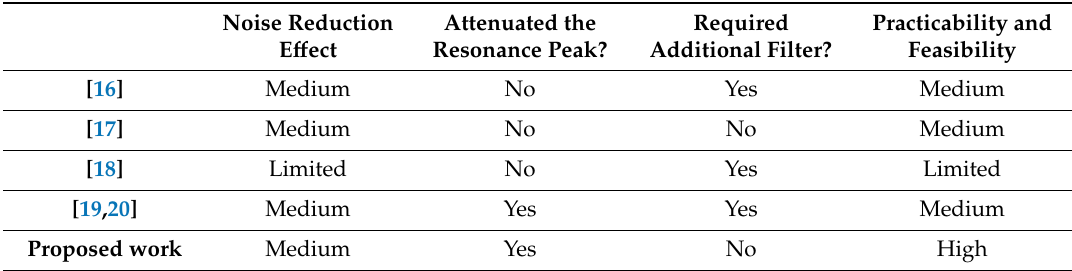
Table 3. Comparison of noise optimization e ff